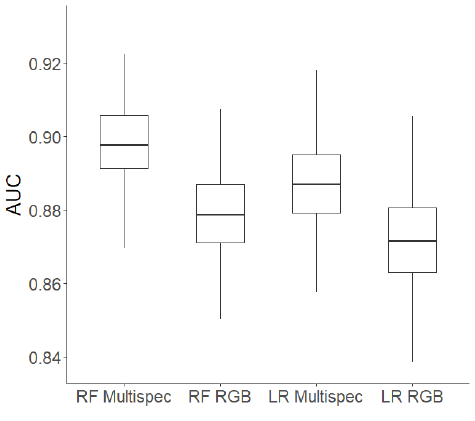
Figure 3. Mean area under the receiver operating characteristic curve (AUC) values for random forest (RF) and logistic regression (LR) models that included multispectral indices or that used indices derived from visible reflectance only, using 200 different randomly assigned training and testing data